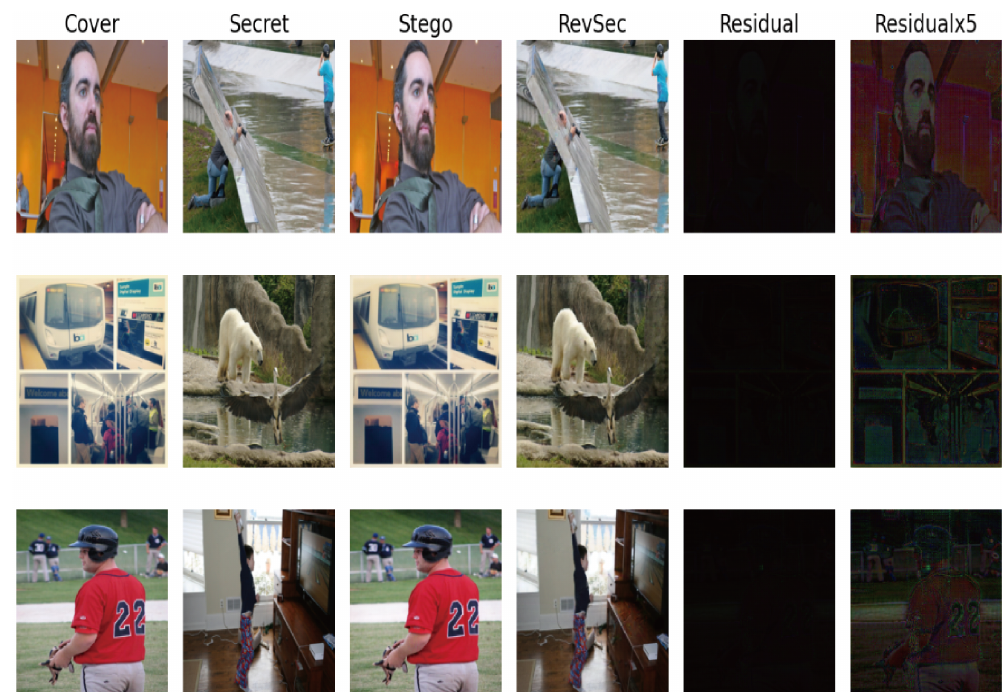
Figure 10. Test results of our proposed scheme on